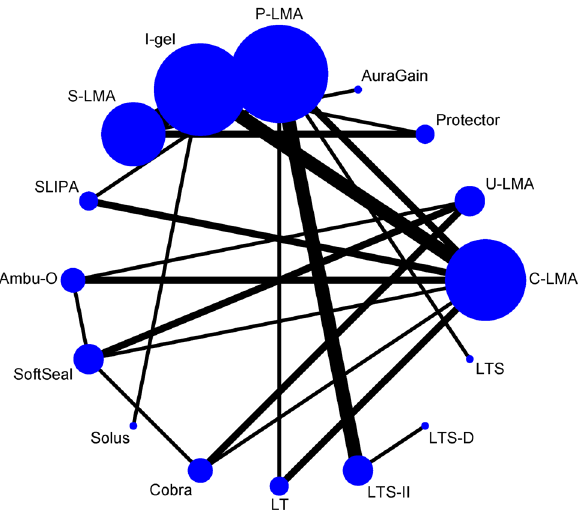
Figure 4. Network of eligible supraglottic airway device comparisons for postoperative sore throat rate. The line indicates the number of trials and the dots indicate the number of patients. C-LMA, LMA Classic; U-LMA, Unique LMA; Protector, LMA Protector Airway; AuraGain, Ambu AuraGain Disposable Laryngeal Mask; P-LMA, Proseal LMA; I-gel, I-gel supraglottic airway; S-LMA, Supreme LMA; SLIPA, Streamlined Liner of the Pharynx Airway; Ambu-O, Ambu AuraOnce; Air-Q, Air-Q Masked Laryngeal Airway; SoftSeal, The Portex Soft Seal Laryngeal Mask; Solus, Solus Standard Laryngeal Mask Airway; Cobra, Cobra Perilaryngeal